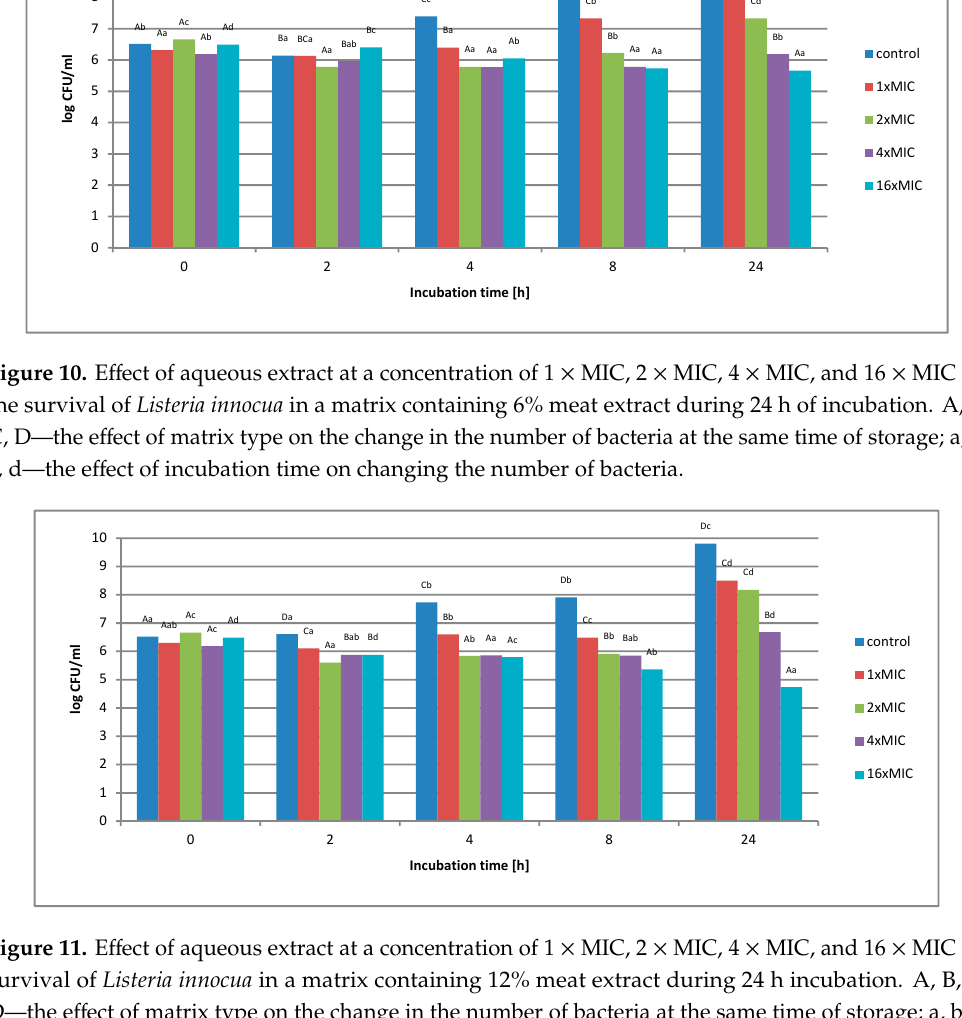
Figure 11. Effect of aqueous extract at a concentration of 1 × MIC, 2 × MIC, 4 × MIC, and 16 × MIC on survival of Listeria innocua in a matrix containing 12% meat extract during 24 h incubation. A, B, C, D—the effect of matrix type on the change in the number of bacteria at the same time of storage; a, b, c, d—the effect of incubation time on changing the number of